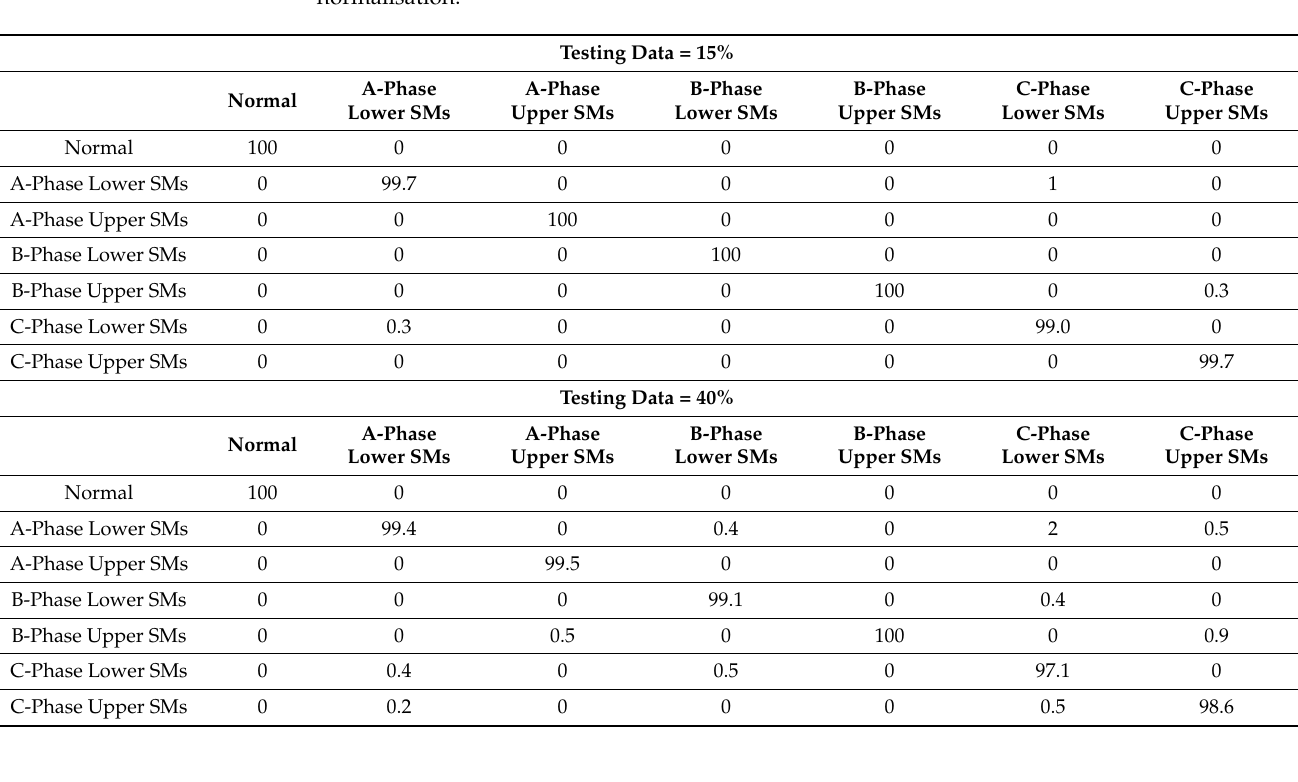
Table 6. Sample confusion matrix of the classification results of MLR-based without data normalisation.